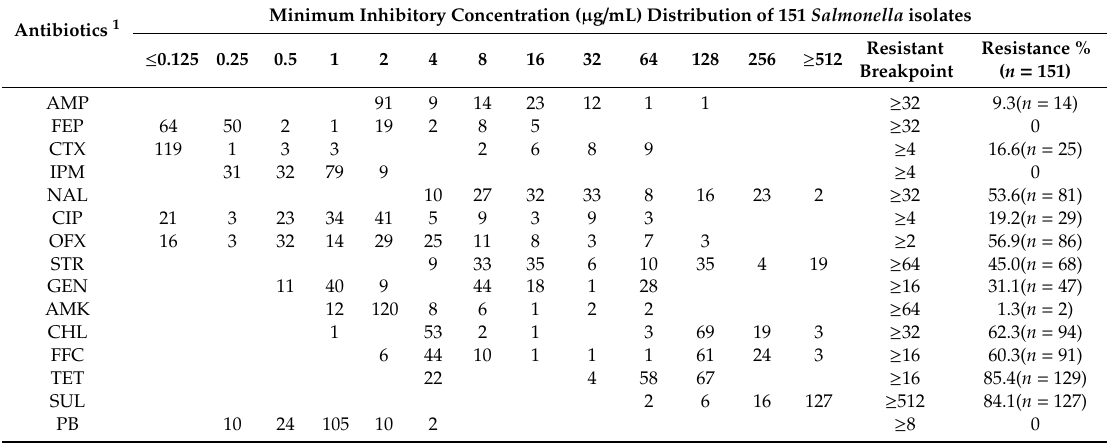
Table 2. Antimicrobial resistance phenotypes of Salmonella isolates ( n = 151). Minimum Inhibitory Concentration ( µ g / mL) Distribution of 151 Salmonella isolates Antibiotics 1 ≤ 0.125 0.25